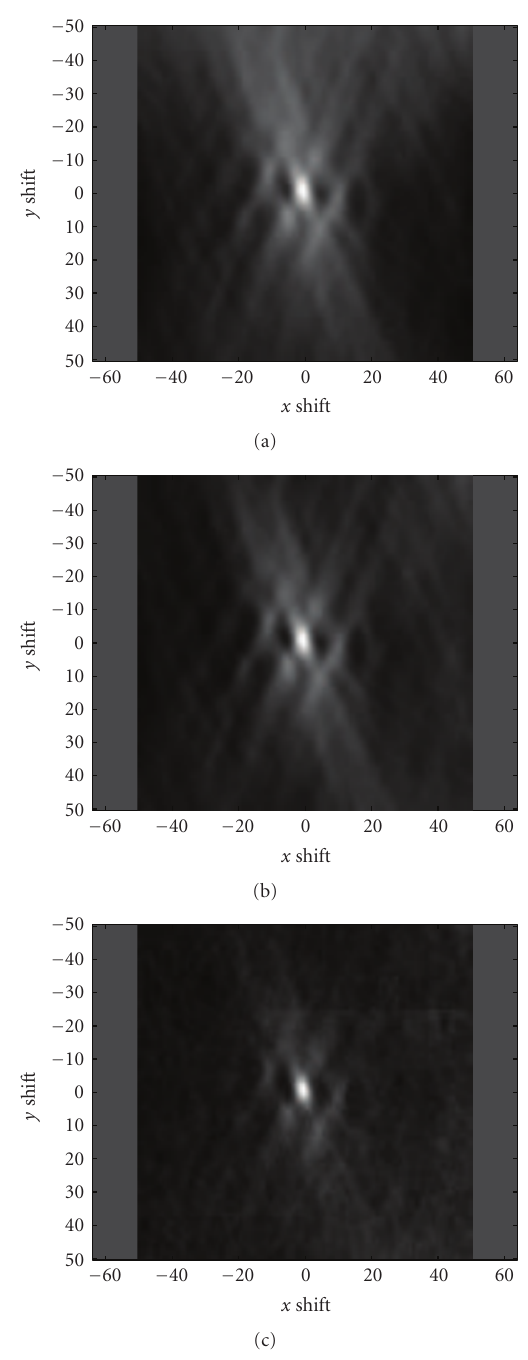
Figure 5: The metric plane shown as 2D images for IR and AF images. The brigthness represents similarity value: (a) MSS, (b) NCC, (c) MI. The proper shift values are located at (0,0) position.